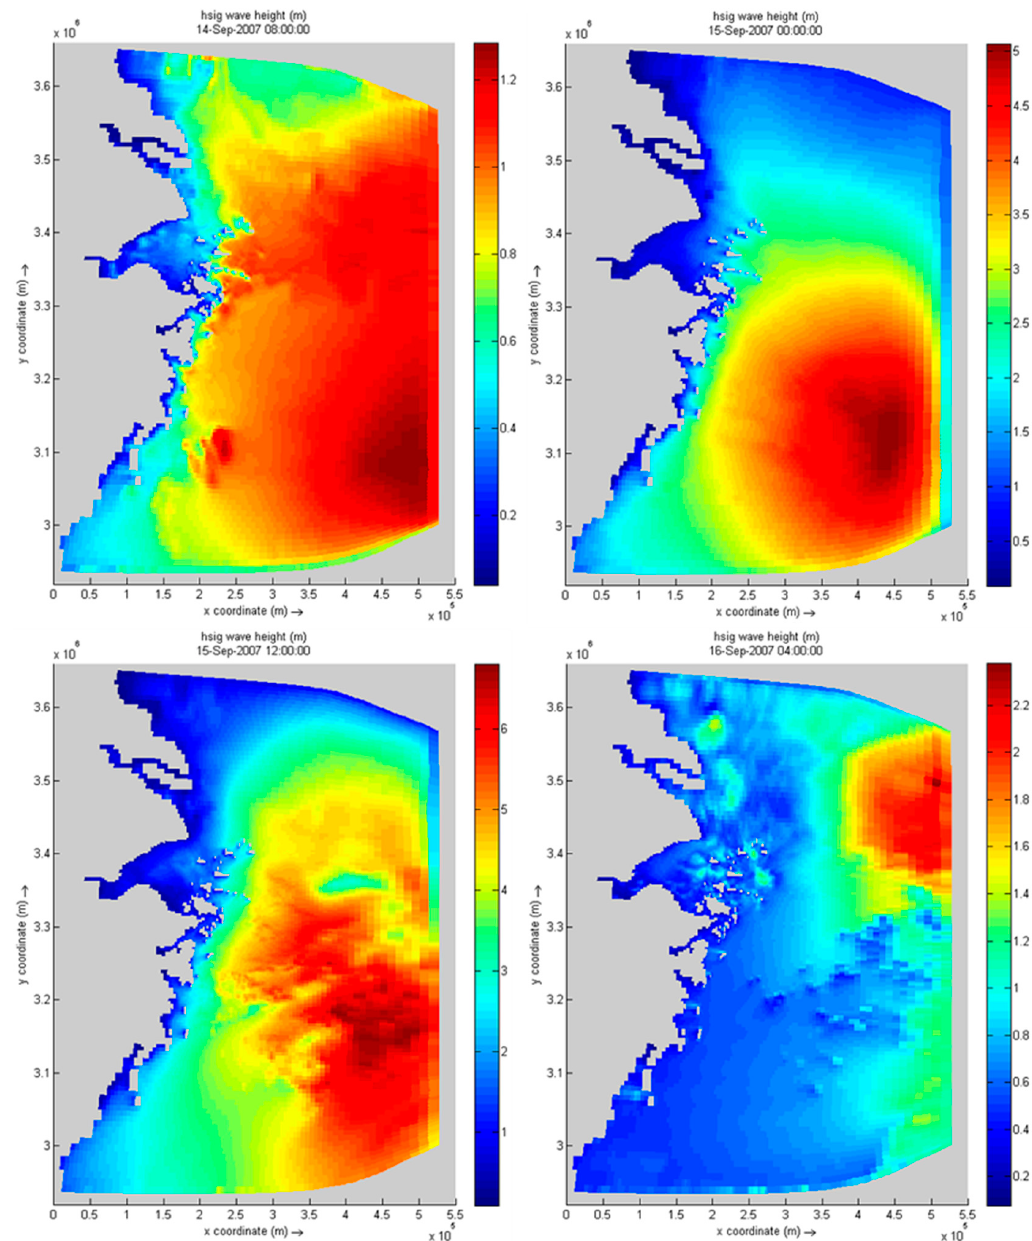
Figure 9. Distribution of effective wave height at four moments under Typhoon Lily.